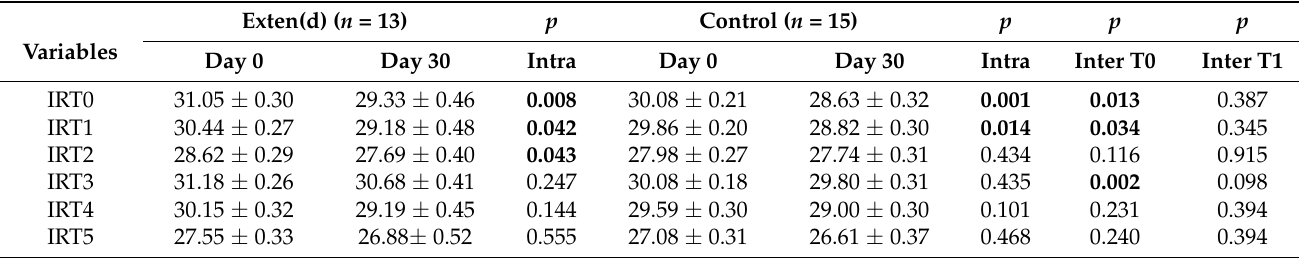
Table 2. Mean knee temperature (°C) during the visit (IRT0–IRT5) after administration of 2 g of Exten(d) for 30 days to volunteers compared to placebo. Values reported are means ± standard error of the mean. Variables